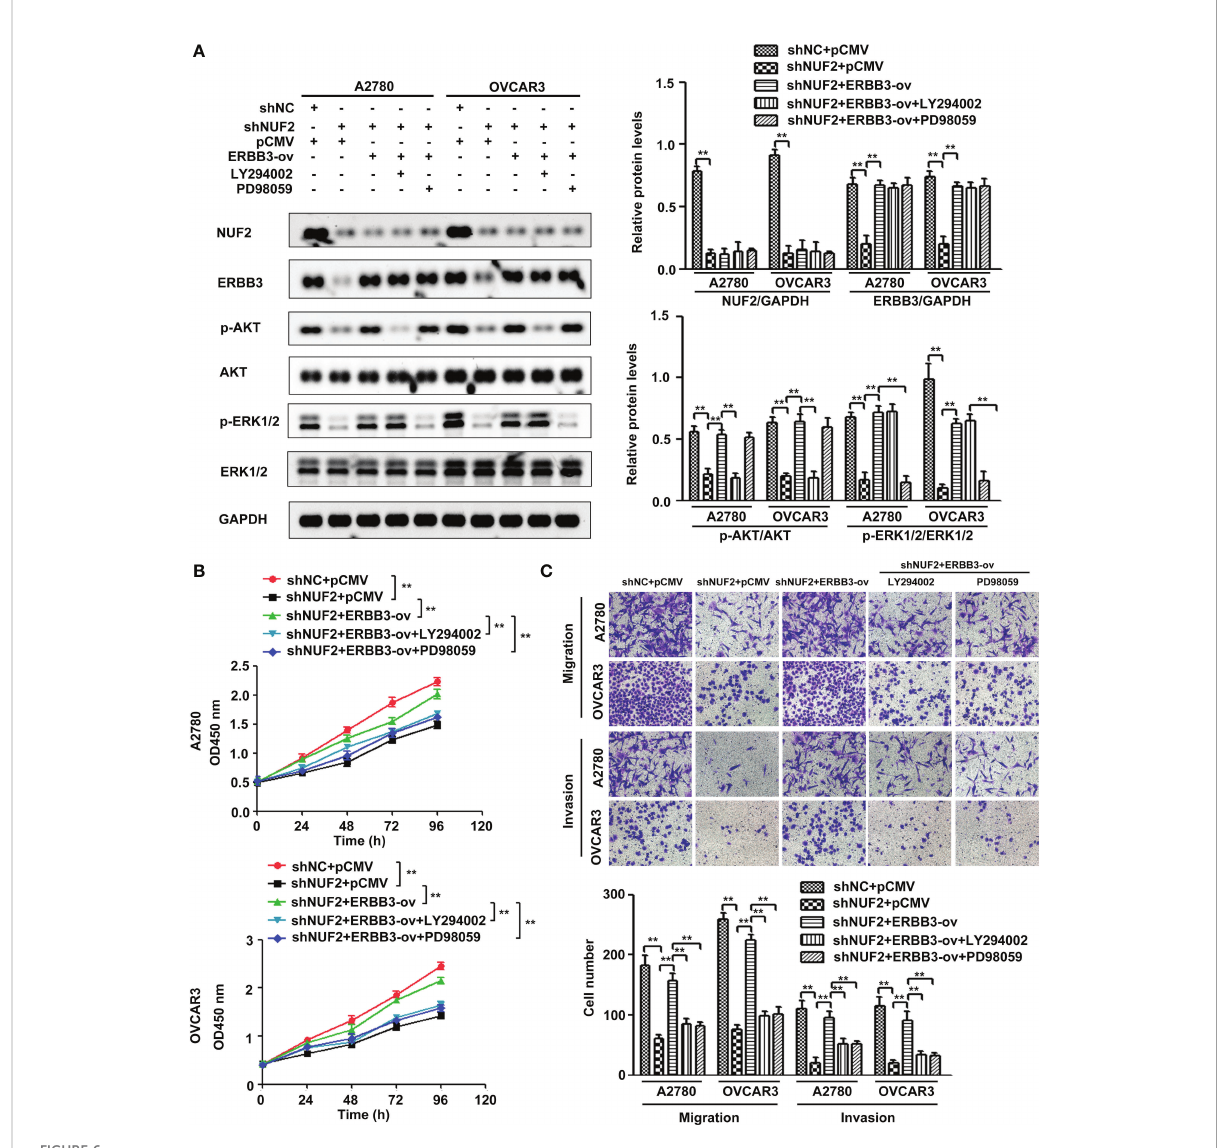
FIGURE 6 NUF2 promotes EOC progression by the ERBB3-mediated PI3K-AKT and MAPK signaling axes. (A) A2780 and OVCAR3 cells were treated with shNC+pCMV, shNUF2+pCMV, shNUF2+ERBB3-ov, shNUF2+ERBB3-ov+LY294002 (15 µM), and shNUF2+ERBB3-ov+PD98059 (10 µM). Western blotting was used to determine the protein expression of NUF2, ERBB3, p-AKT, AKT and p-ERK1/2, ERK1/2. (B, C) CCK-8 and transwell assays were used to determine the effects of ERBB3 restoration on the proliferative, migratory and invasive capacities of NUF2-downregulated cell lines. ** P < 0.01. original magni fi cation, ×